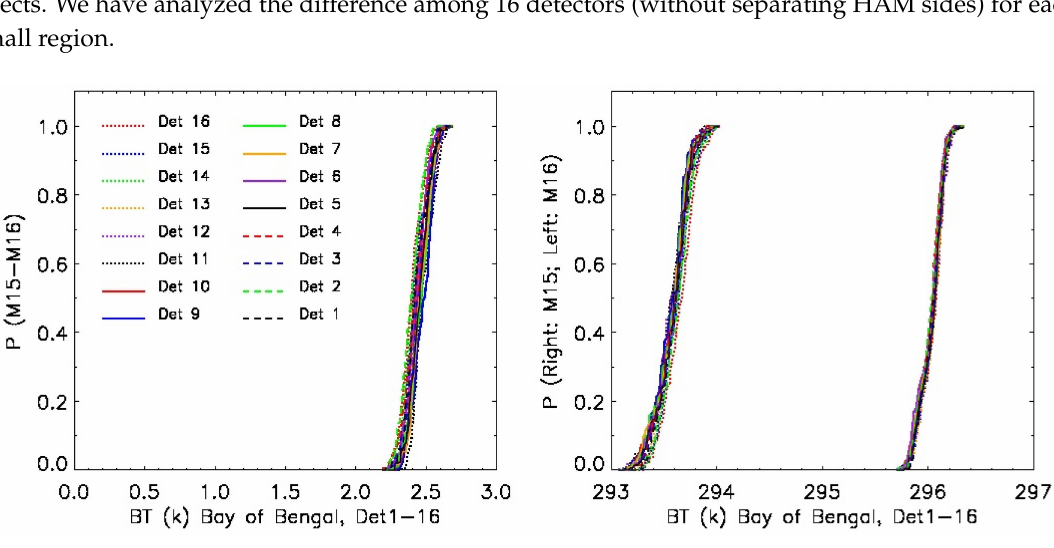
Figure 4. The cumulative histogram for Bay of Bengal over tropical region on 19 June 2013 in M15 ´ M16 ( left ), as well as M15 and M16 ( right